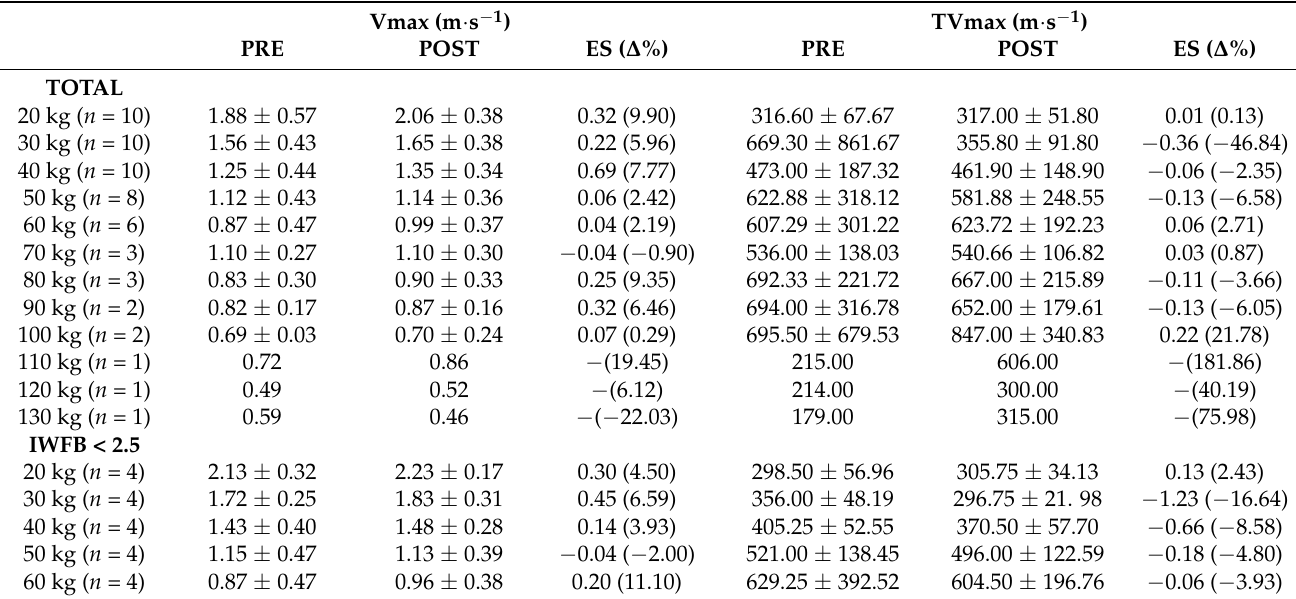
Table 4. Results obtained in both the pretest and the post-test at submaximal intensities of 1RM (V max and TV max ) by all the participants, the IWBF < 2.5 group, and the IWBF > 2.5